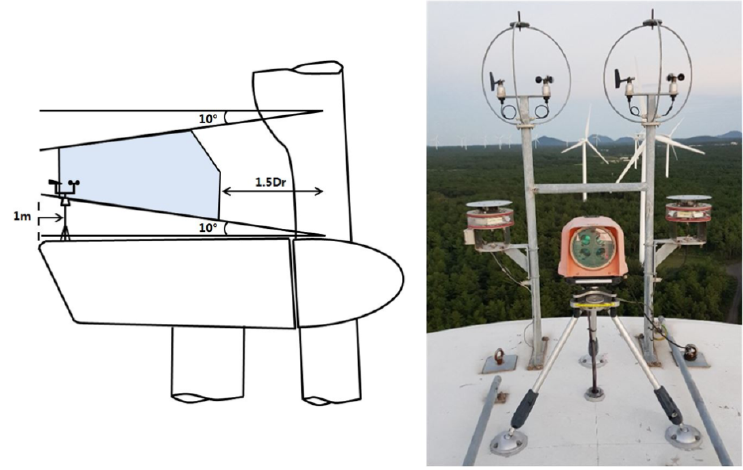
Figure 2. Criteria and actual image for mounting wind sensors with a nacelle LIDAR.